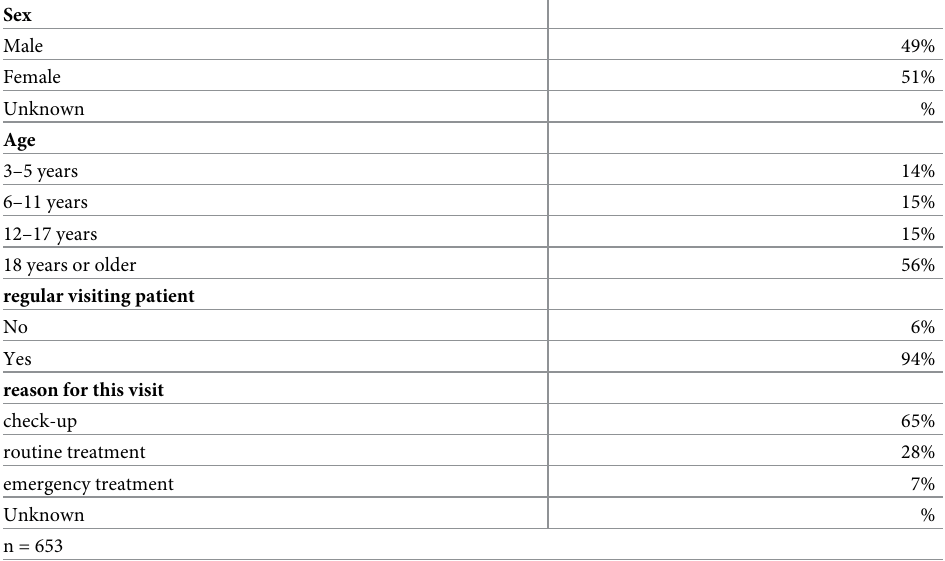
Table 2. Background characteristics of patients, provided by the dentist or an employee of the dental practice.